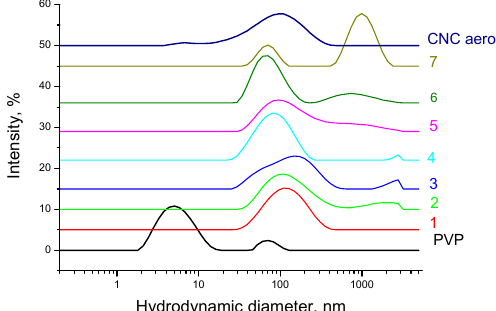
Figure 13. ( a ) Particle size distribution of the PVP/CNC aerogels in water (for comparison, the curves for the neat PVP and CNC are shown): 1—PVP/CNC-4.6 aero; 2—PVP/CNC-10.9 aero; 3—PVP/CNC-16.3 aero; 4—PVP/CNC-19.6 aero; 5—PVP/CNC-28.9 aero; 6—PVP/CNC-37.9 aero; 7—PVP/CNC-54.5 aero. ( b ) Surface charge of PVP coated CNC particles after redispersion of the PVP/CNC aerogels in water.